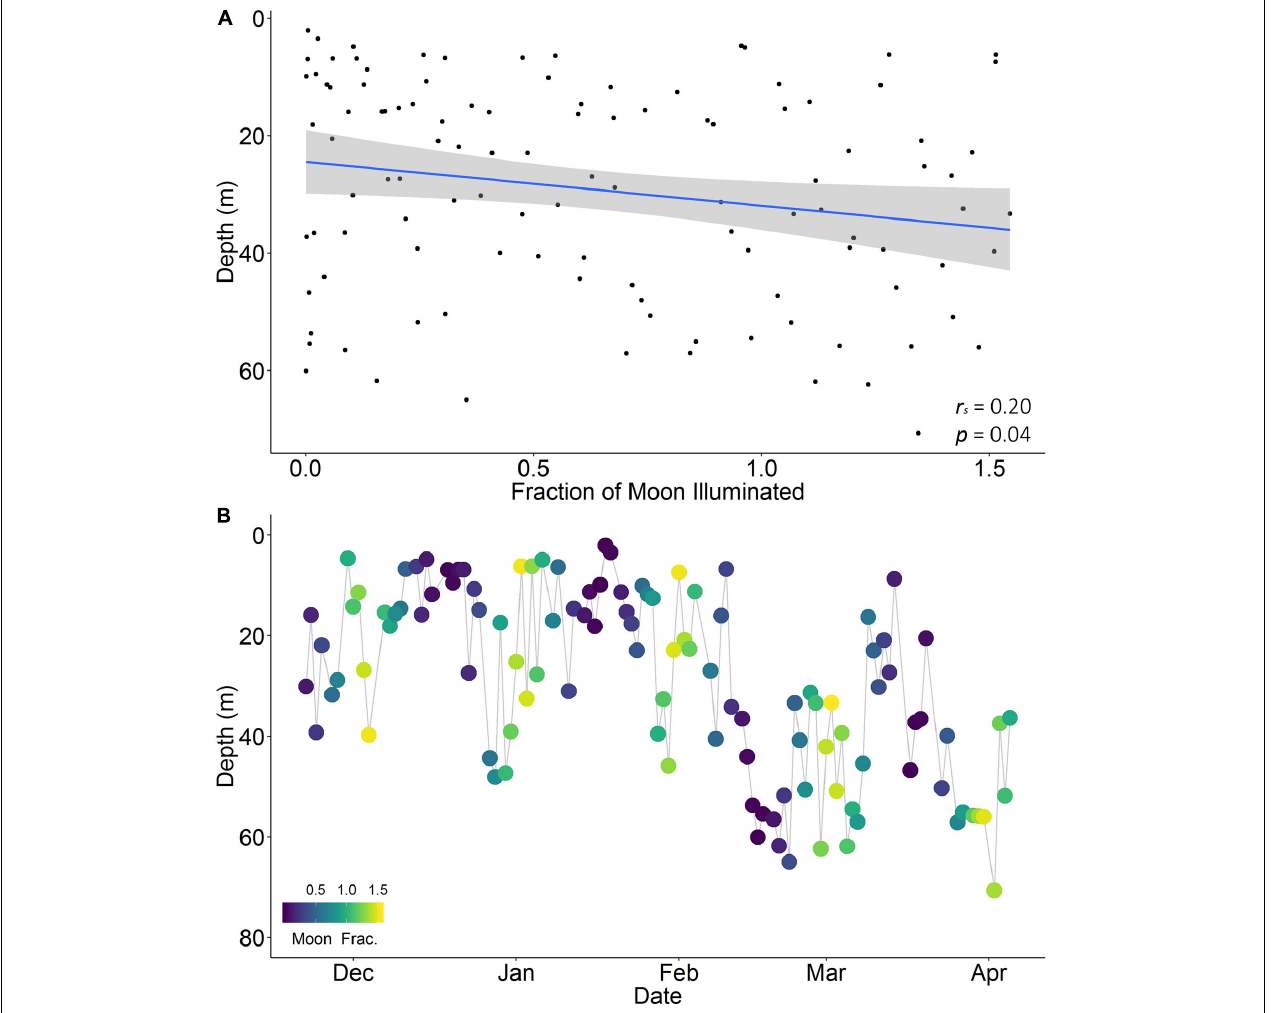
FIGURE 7 | Nightly average dive depth relative to moon illumination (arcsine transformed; A ) and over time (November 2017 to April 2018; B ) for a female reef manta ray ( Mobula alfredi ; M5) tagged with pop-up archival satellite tag in Seychelles. Blue line indicates direction of relationship with moon illumination based on a Spearman’s rank correlation. Gray shading indicates 95% confidence interval. Note that this is the only individual of five to display a significant